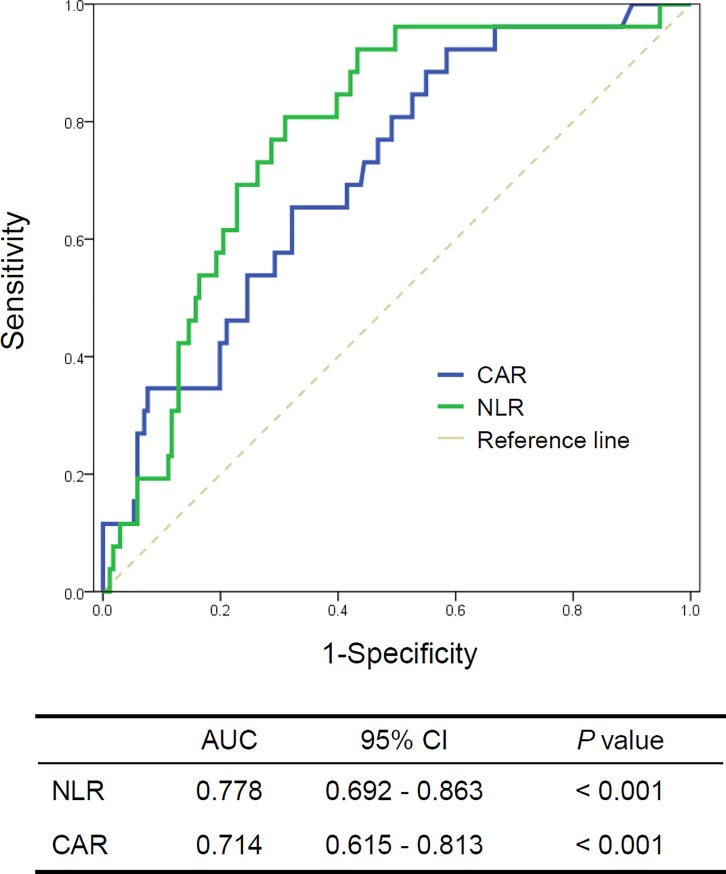
Receiver operator characteristic curves for predicting non-survival in patients with idiopathic inflammatory myopathy.NLR, neutrophil-to-lymphocyte ratio; CRP, C-reactive protein; CAR, CRP-to-albumin ration; AUC, area under the curve; CI, confidence interval.